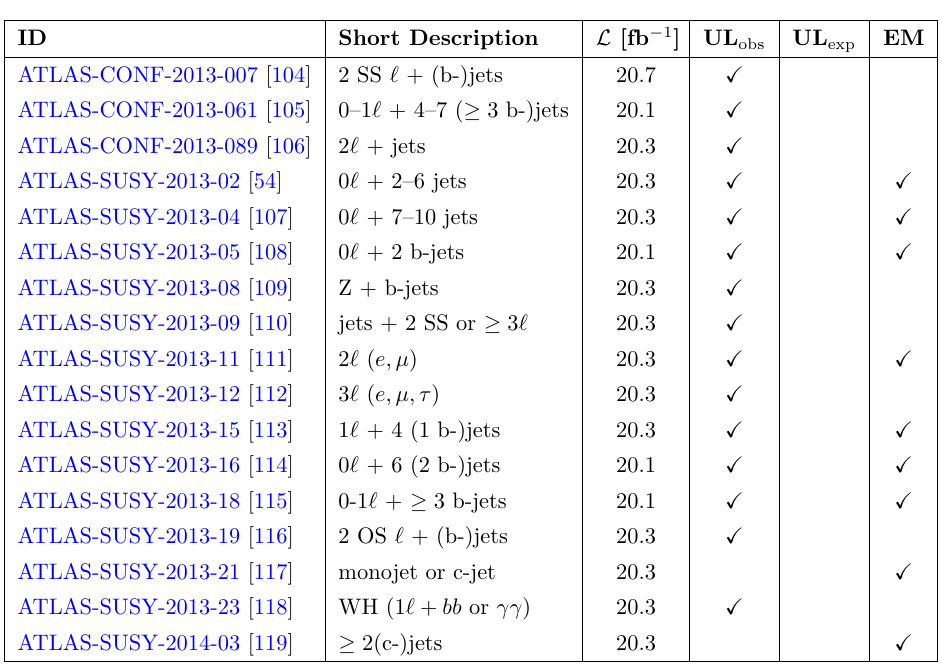
Table 7 . List of ATLAS Run 1 analyses and their types of results in the SModelS v1.2.4 database. The column “comb.” is omitted as no information on signal region correlations is available for any of the analyses.